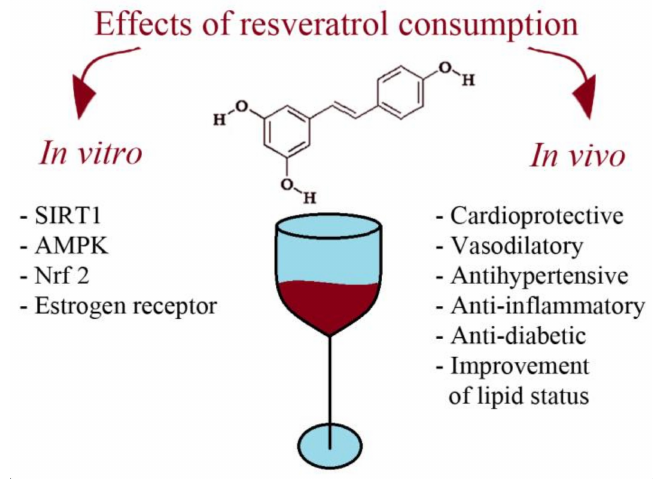
Figure 2. Anti-CVD effects of resveratrol found in in vitro and in vivo